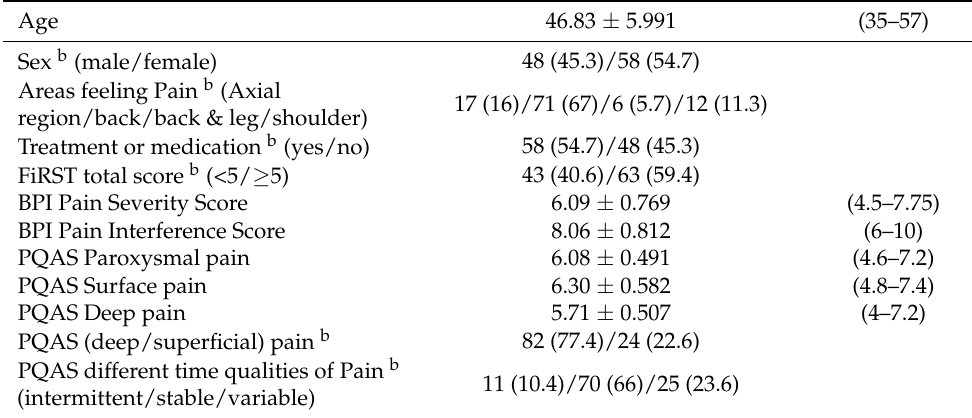
Table 1. Demographic data and pain characteristics of the subjects a (n = 106).